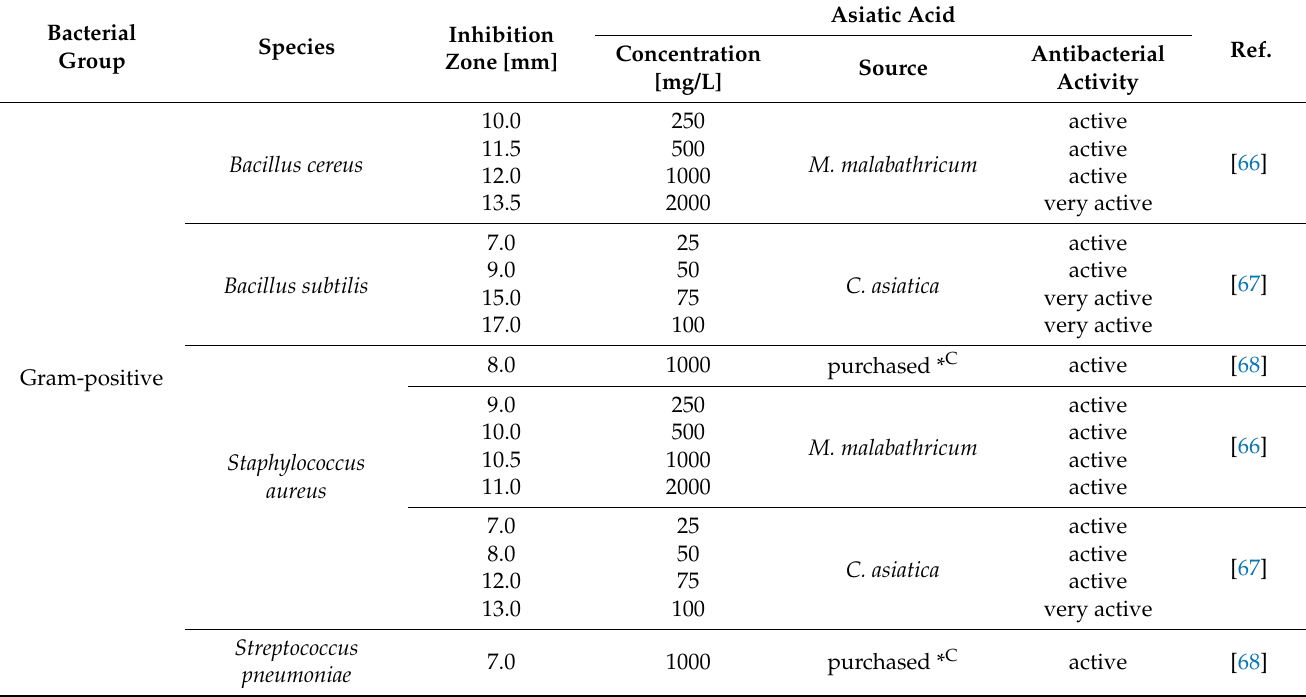
Table 2. Growth inhibition zones and corresponding concentration values of asiatic acid against Gram-positive and Gram-negative